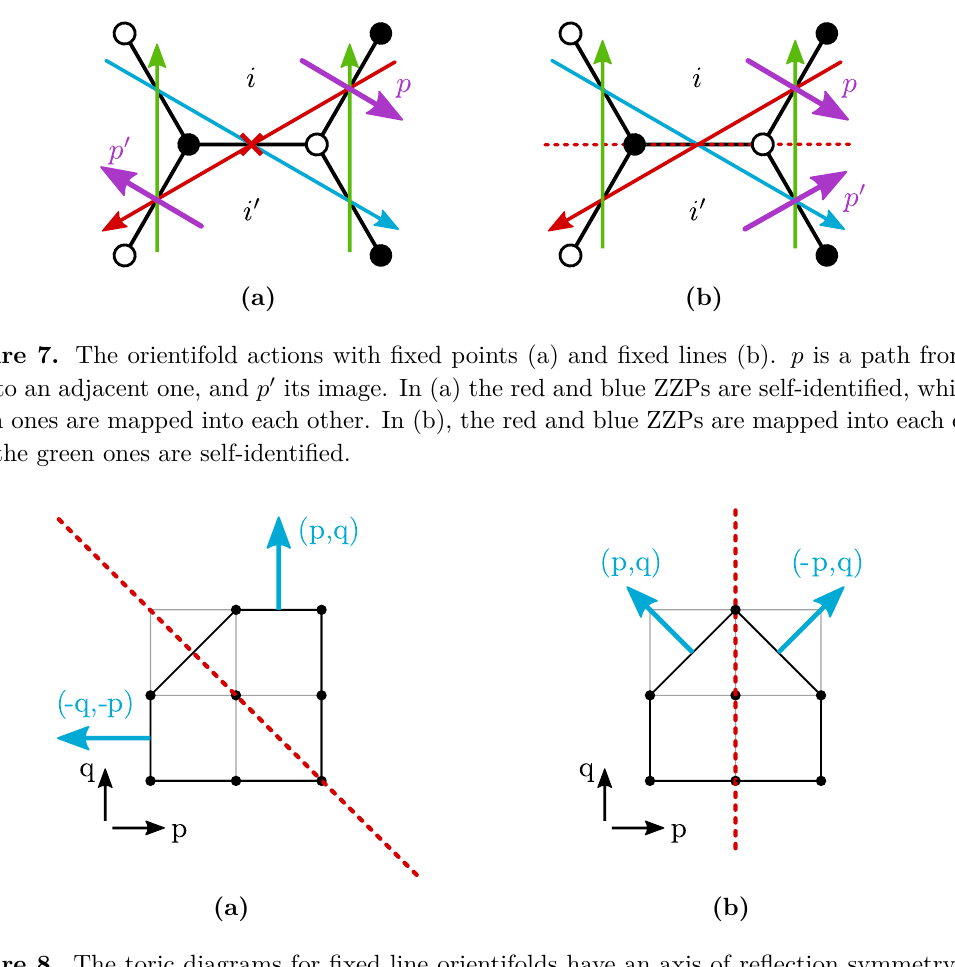
Figure 8. The toric diagrams for fixed line orientifolds have an axis of reflection symmetry. The corresponding axes for: (a) diagonal and (b) horizontal O-lines. In both cases we show in blue a generic ZZP and its